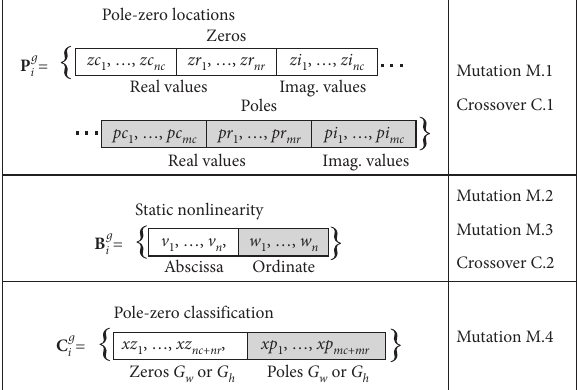
Figure 7: Structure of an individual and genetic operations per- formed on each piece of genetic